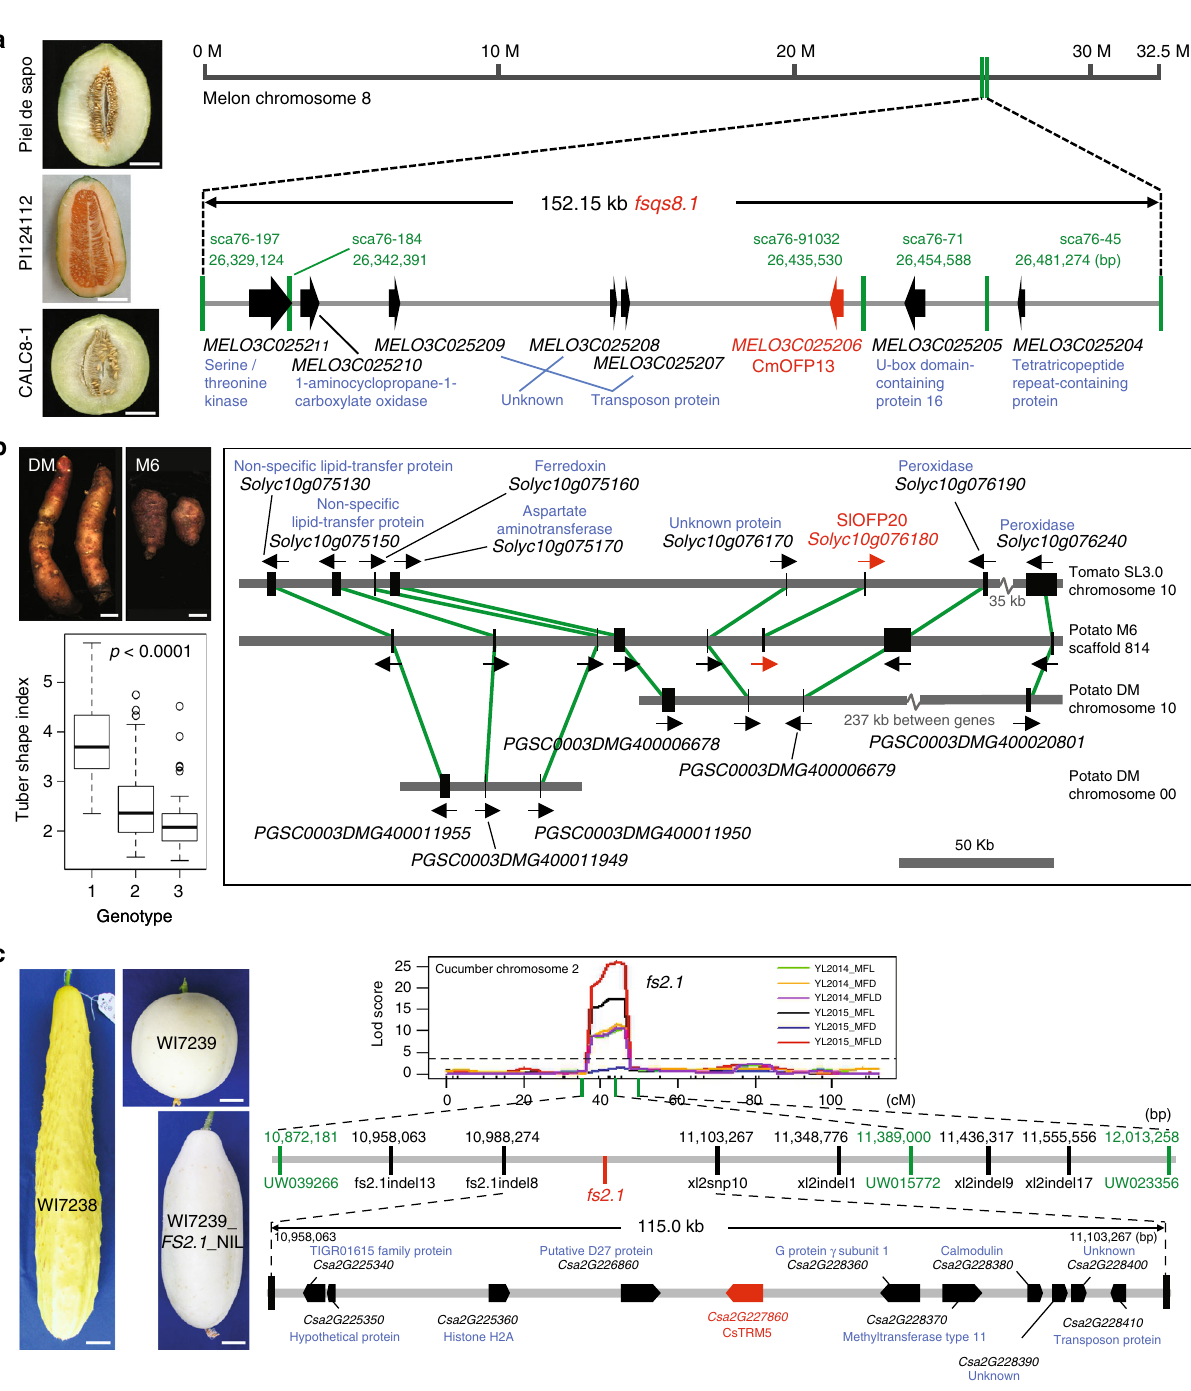
Fig. 6 Association of OFP and TRM in regulating fruit and tuber shape in domesticated crops. a Fine-mapping of fsqs8.1 in melon to CmOFP13 . Fruit shapes of the parental lines and the CALC8-1 NIL that carries the PI124112 allele of fsqs8.1 in the Piel de Sapo background. Scale bar, 5 cm. b Association of tuber shape with StOFP20 in potato. 1, homozygous DM1-3 allele; 2, heterozygous; 3, homozygous M6 allele. The green lines connect the syntenic orthologous gene pairs in tomato and the two potato accessions around SlOFP20 . Scale bar, 1 cm. c Fine-mapping of the cucumber fs2.1 locus. The LOD curve from the cucumber F 2 population led to candidate gene identi fi cation including CsTRM5 , an ortholog of SlTRM5 . Likely candidate genes are denoted in red. Other gene annotations are denoted in blue. Scale bar, 2.5